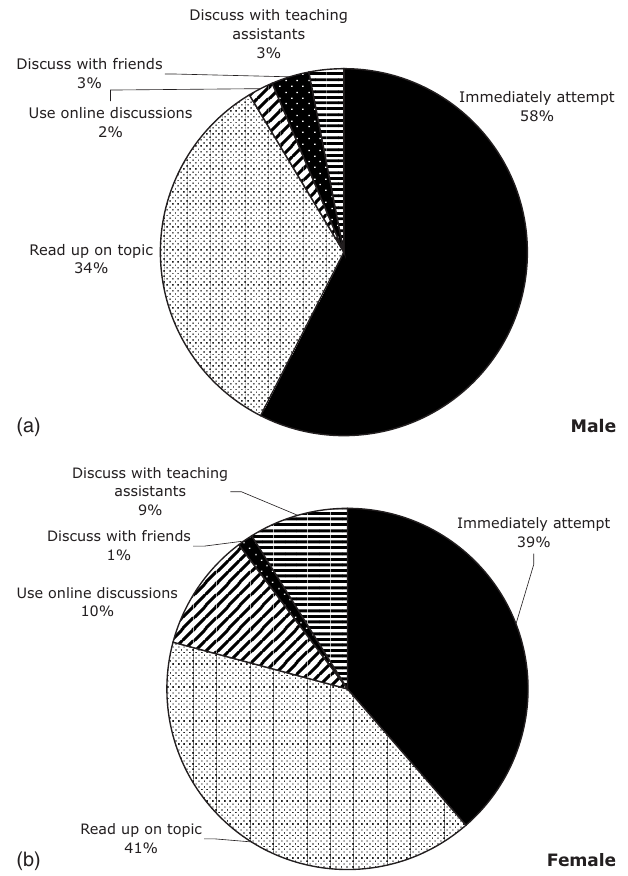
FIG. 3. First actions that students report taking on online home- work problems. The top panel reflects the statements of male stu- dents, while the bottom panel reflects those of female